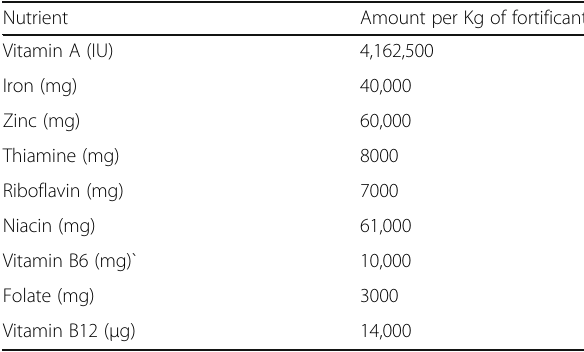
Table 1 Nutrient Composition of Micronutrient Fortificant